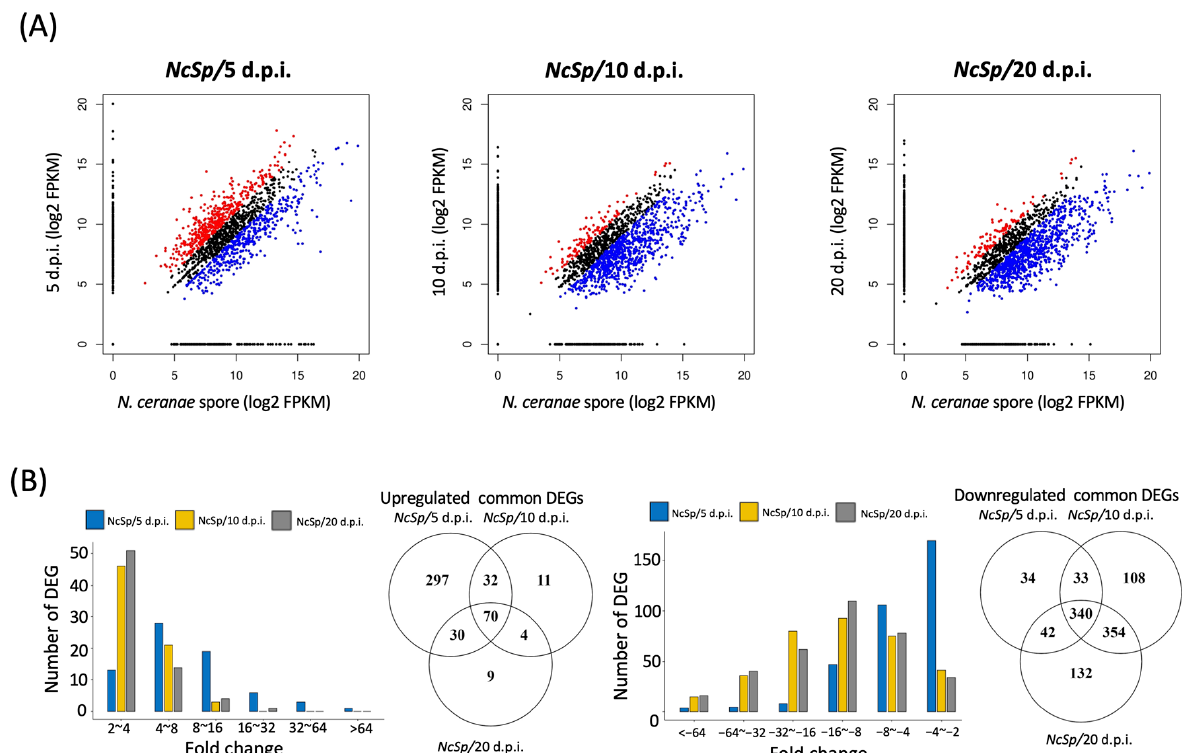
Figure 2. DEG and common gene identification. ( A ) Scatter plot of DEGs (red dots = upregulation and blue dots = downregulation); ( B ) Venn plot and fold-change number for the distribution of common